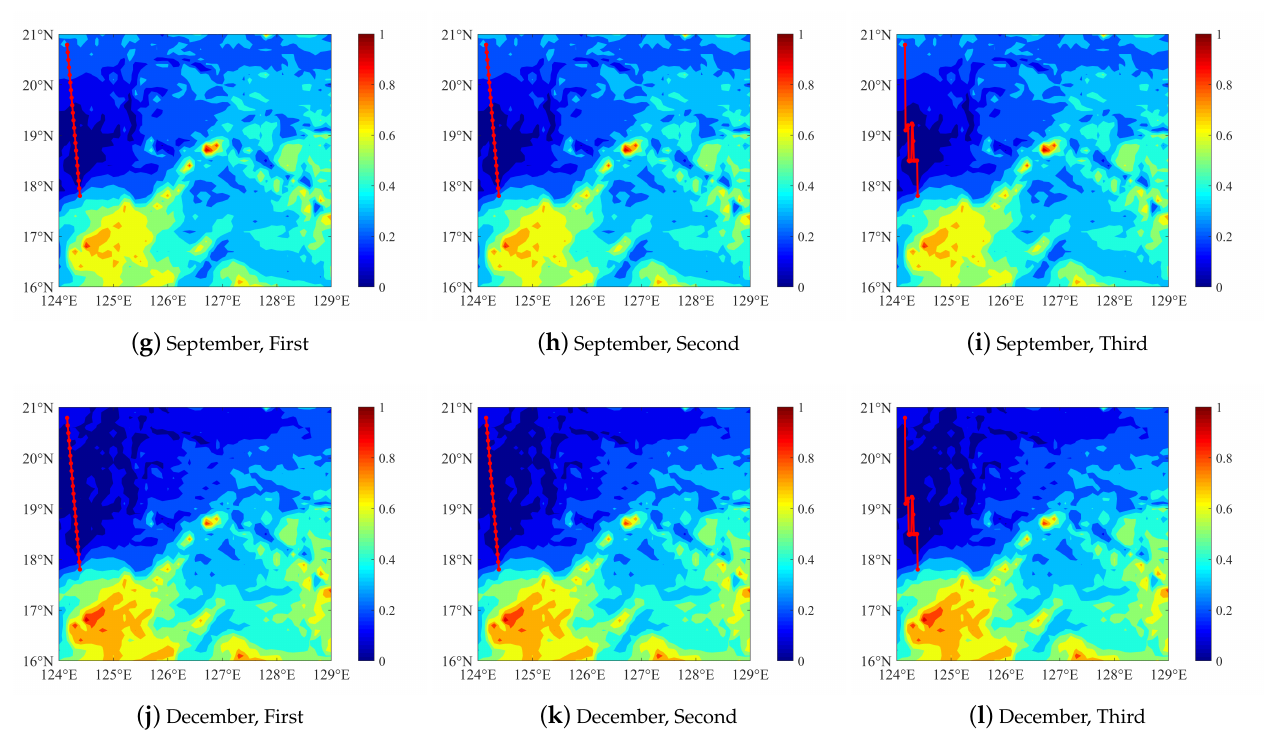
Figure 7. Three-times optimized observation schemes in different months based on a simple cost